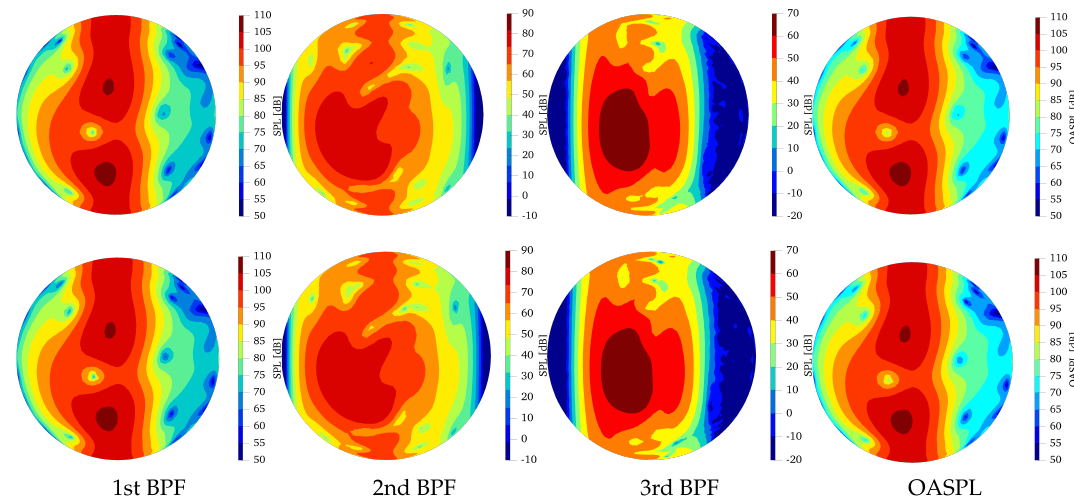
Figure 12. Sound directivity of rotor #1 for the case dist = 0, for a three rotors configuration. The first row shows the noise sphere from below, the second one from